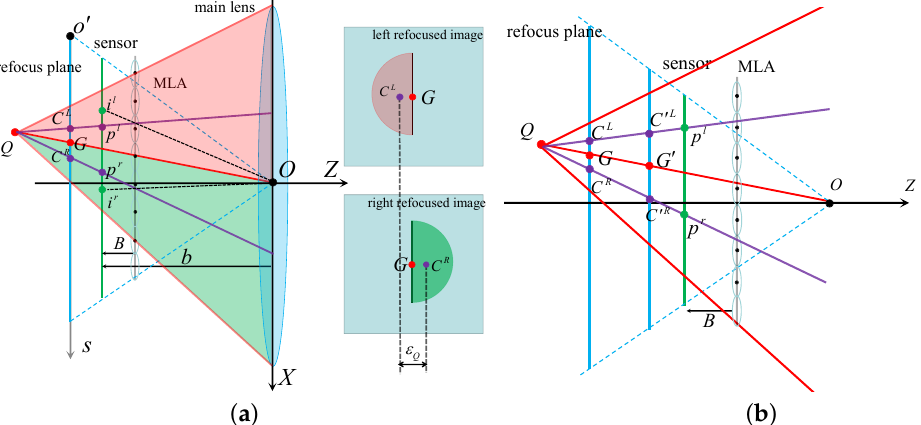
Figure 5. Illustration of parallax in central projection stereo focal stack (CPSFS). ( a ) Central projection stereo refocused image pair. ( b ) Parallax of Q in